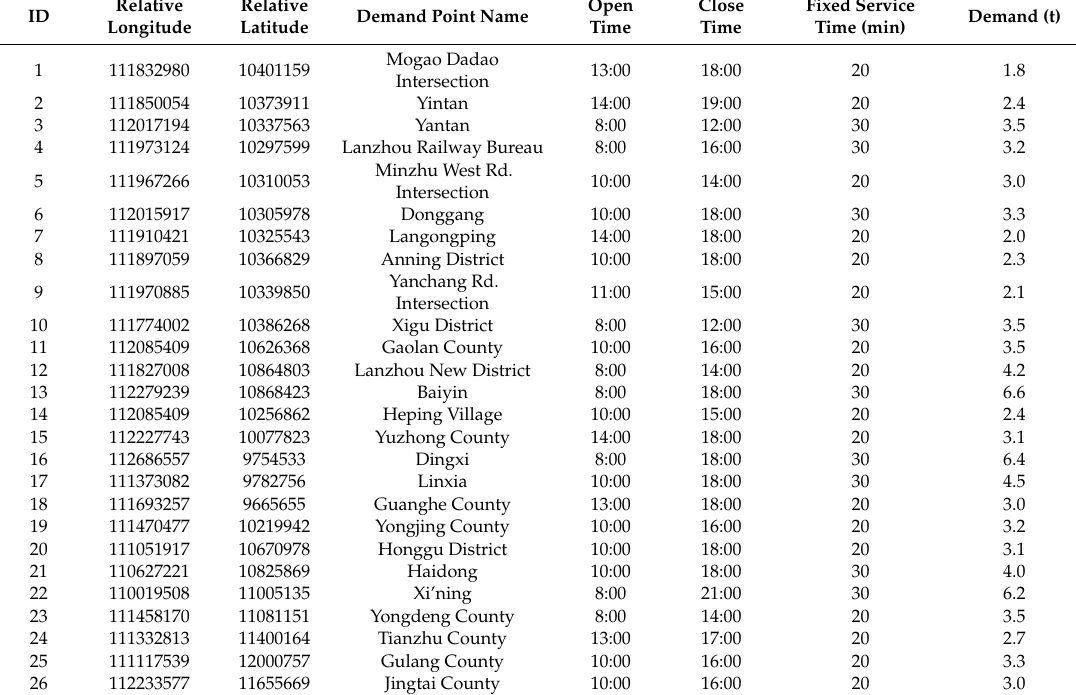
Table 4. Demand point layer attribute data.